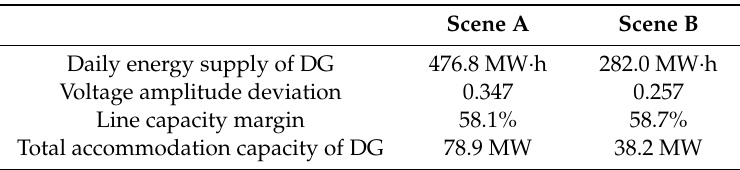
Table 4. Optimal compromise solutions under two scenes.